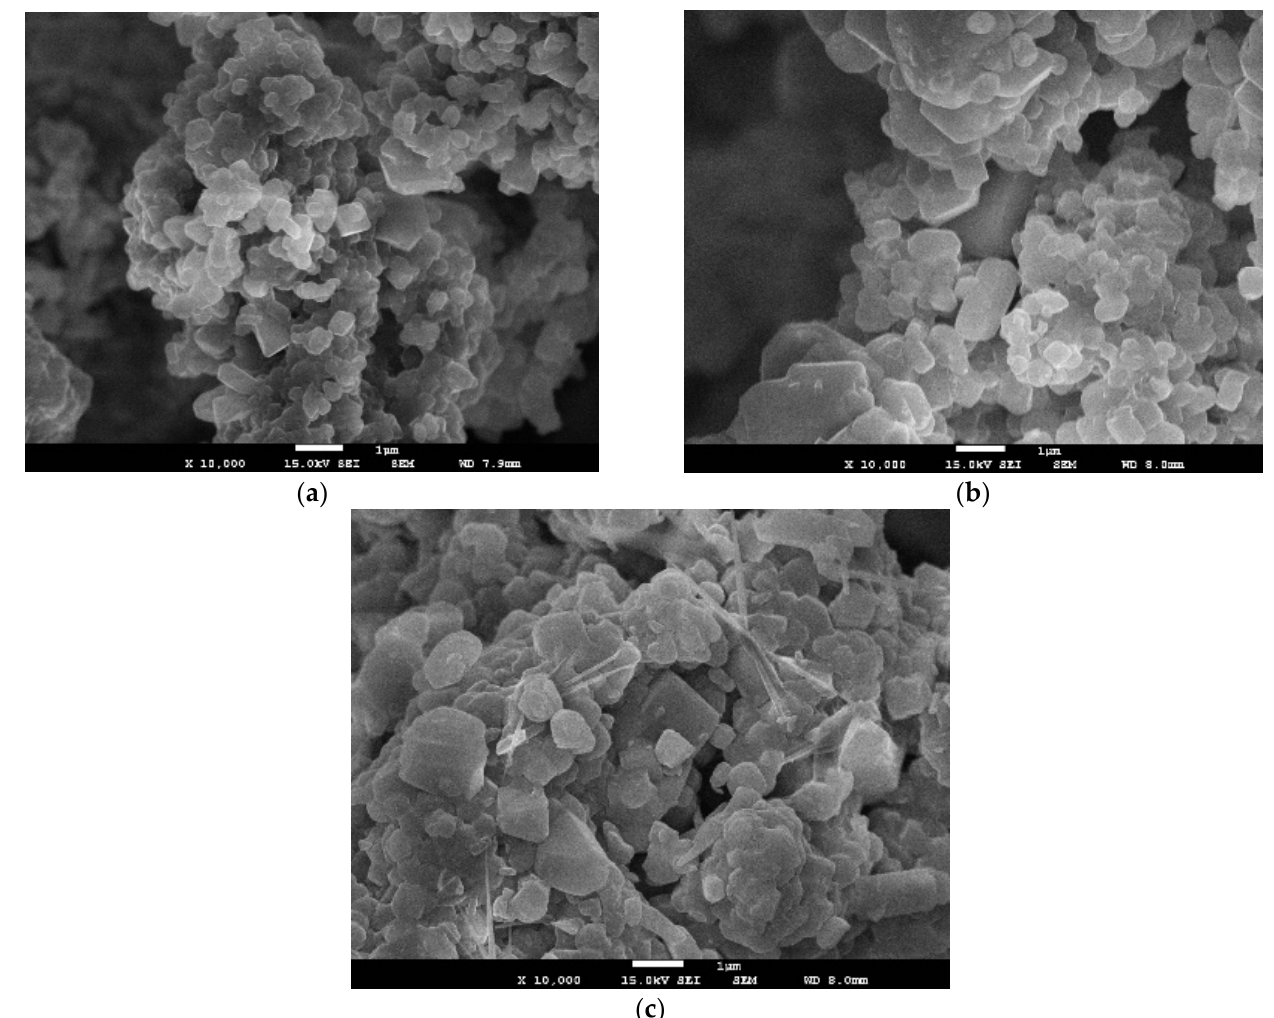
Figure 5. SEM micrographs of ( a ) 0.3Li 2 MnO 3 –0.7LiNi 0.5 Mn 0.5 O 2 , ( b ) 0.5Li 2 MnO 3 –0.5LiNi 0.5 Mn 0.5 O 2 , and ( c ) 0.7Li 2 MnO 3 –0.3LiNi 0.5 Mn 0.5 O 2 cathode material